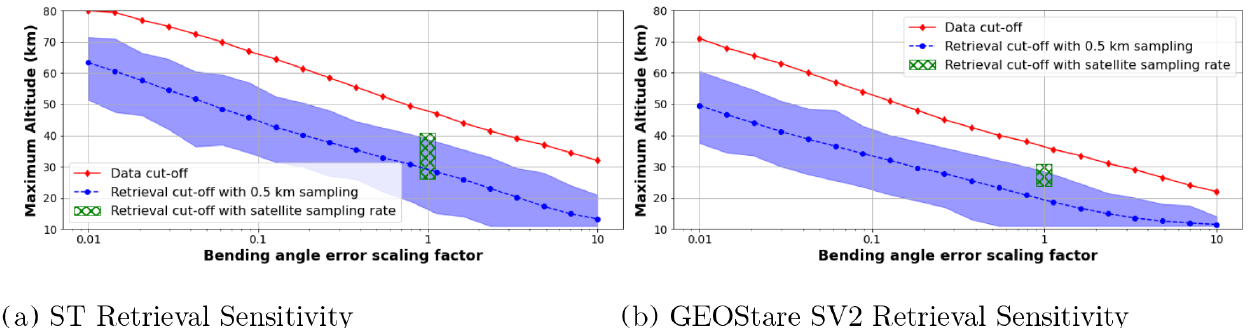
Figure 7. Maximum altitude of retrieved atmospheric sounding profile analysis for each satellite measurement. The red diamonds show the data cut-off due to a degraded SNR relative to the amount of added bending angle noise. The maximum altitude according to a threshold of 2% error in retrieved temperature is shown with the mean and range of the ensemble in blue circles and blue shaded area, respectively. The maximum altitude of 10% error in retrieved temperature utilizing the observed vertical resolution is shown in the green hatched area for the lowest to highest vertical resolution of each